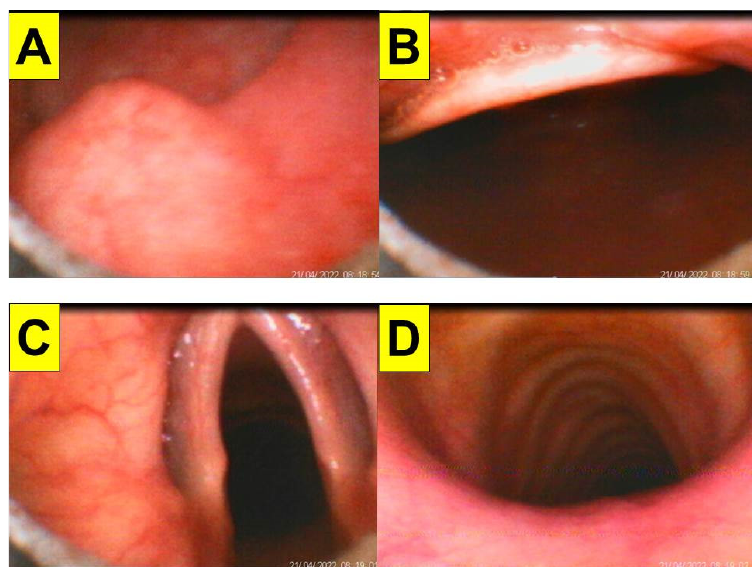
Figure 10. Application of the Shikani technique and plastic sheet barrier in the patient receiving double-lumen endobronchial tube insertion. ( A ) Entry into oral cavity and both the uvula and palates were seen; ( B ) localization of epiglottis; ( C ) glottic view with open vocal cords; ( D ) ready for railroading the tube into trachea. The time for intubation (from lip to trachea) is 14 s (see also the video clip in the Supplementary Materials Video S4).